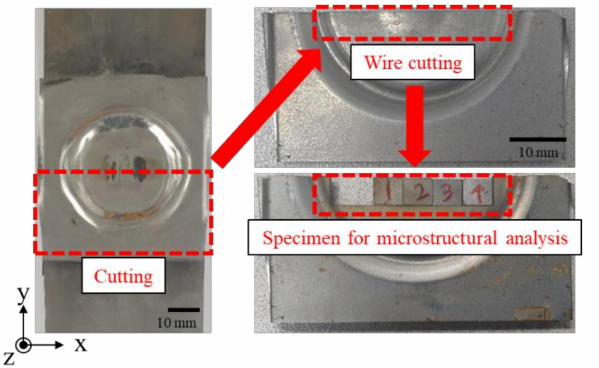
Figure 15. Preparation for microstructural investigation in the welded VFAW specimen.